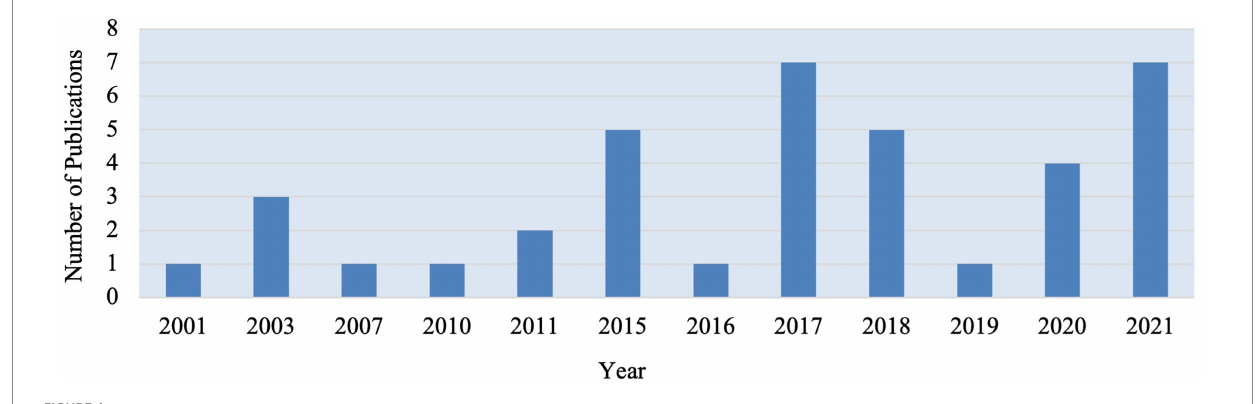
FIGURE 4 Publication trends regarding the use of technology in modelling.